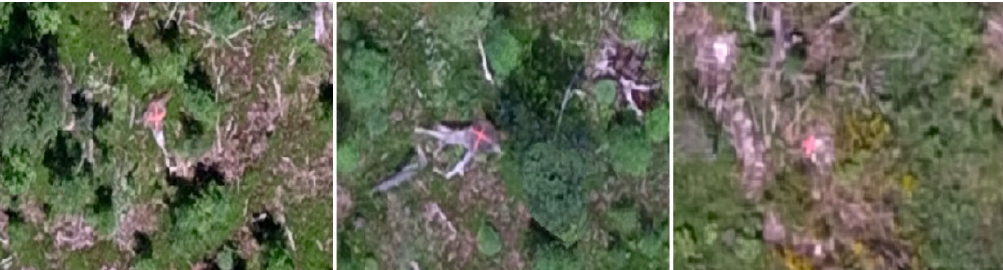
Figure 3. Identification of checkpoint centres using orange tree-marker spray.